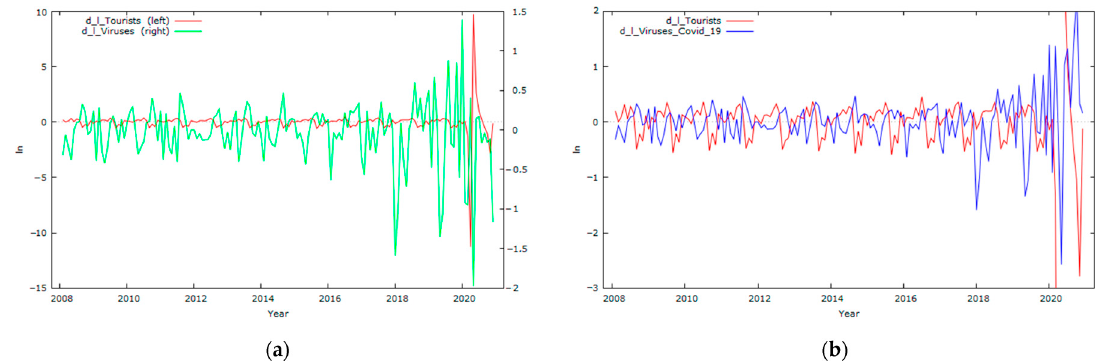
Figure A2. Dispersion of data for time series. ( a ) Between the ∆ ARR t − 1 and ∆ VI t − 1 ; ( b ) Between the ∆ ARR ∆ 19 t t − 1 and